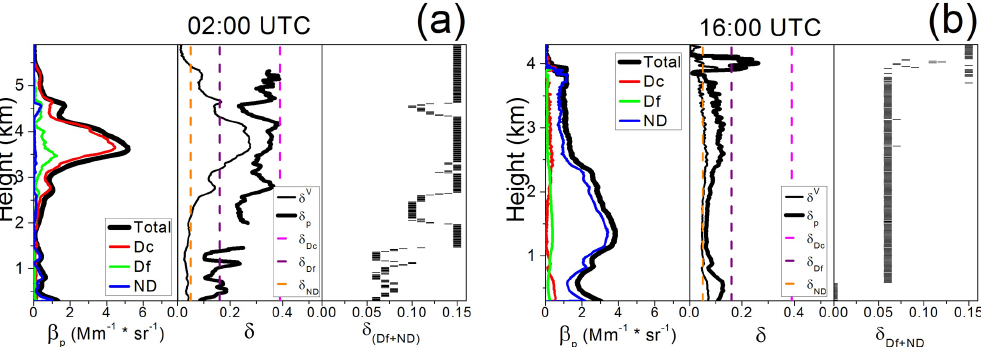
Figure 4. Dust event on 5 July 2016. Vertical profiles of the particle backscatter coefficients (total and for each specific component; left pan- els), the linear depolarization ratios (volume δ V and particle δ p ; centre panels) and the estimated depolarization ratio for the fine (Df + ND) mode ( δ Df + ND ; right panels) at two time intervals, illustrating the different aerosol scenarios observed throughout the day: (a) at 02:00UTC (high dust incidence) and (b) at 16:00UTC (low dust incidence). Specific depolarization ratios selected for each pure aerosol component are also shown by vertical dashed lines (see legend) in the centre